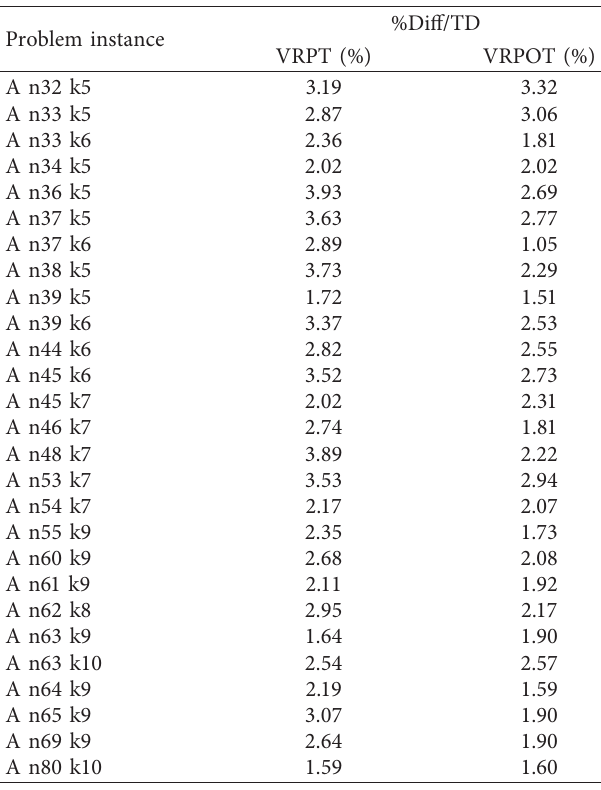
Figure 6: Result comparison of VRPT and VRPOT to the lower bound and upper bound. Table 6: Percentage of additional cost per unit of satisfied transshipment